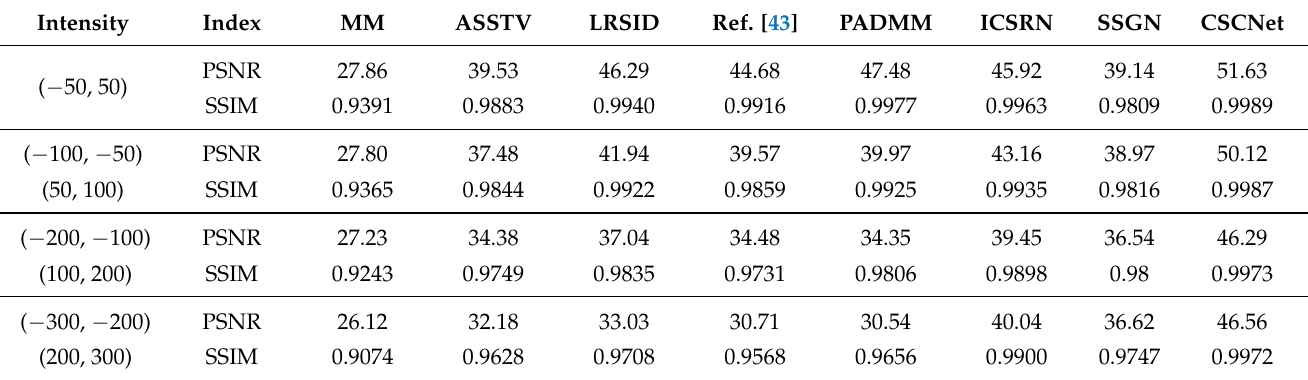
Table 2. PSNR and SSIM of the urban images with different stripe noise intensities.